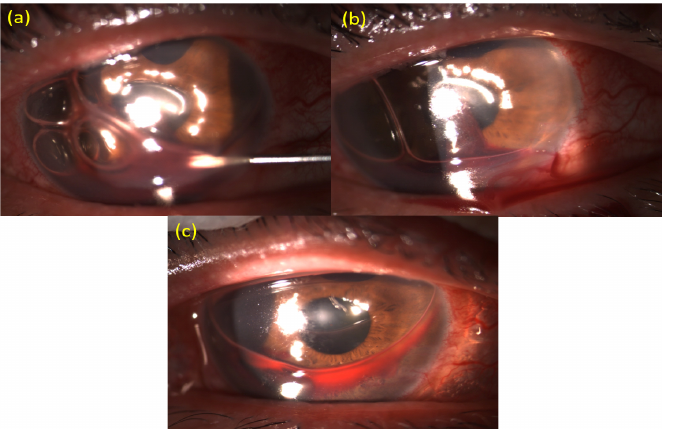
Figure 2. Photos of “air–blood exchange under a slit-lamp” for the management of severe hyphema. ( a ) A 1-cc syringe with a 25-gauge needle was filled with room air or 12% perfluoropropane (C3F8) and inserted through the inferotemporal limbal cornea of left eye or inferonasal limbal cornea of right eye, as close to the 4 o'clock position as possible, under a slit-lamp biomicroscope. Room air or 12% C3F8 was then injected through the syringe. ( b ) The syringe was then removed from the inferotemporal limbal cornea of the left eye or the inferonasal limbal cornea of the right eye. We then used a cotton wool swab to gently push around the 1-mm clear cornea incision at the 6 o'clock position under the slit-lamp. The blood in the anterior chamber was then drained from the clear cornea incision; therefore, the blood can be seen outside the cornea at the 6 o'clock position in this figure. ( c ) With the “air–blood exchange” procedure, most of the hyphema was drained, and the anterior chamber is filled with air bubbles. The visual axis is clear without any blood clots.